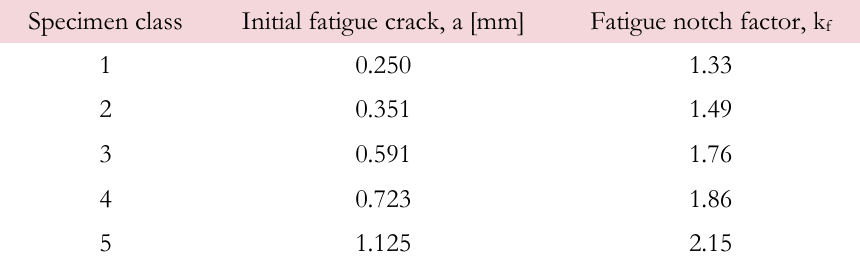
Table 5: Values of fatigue notch factors.